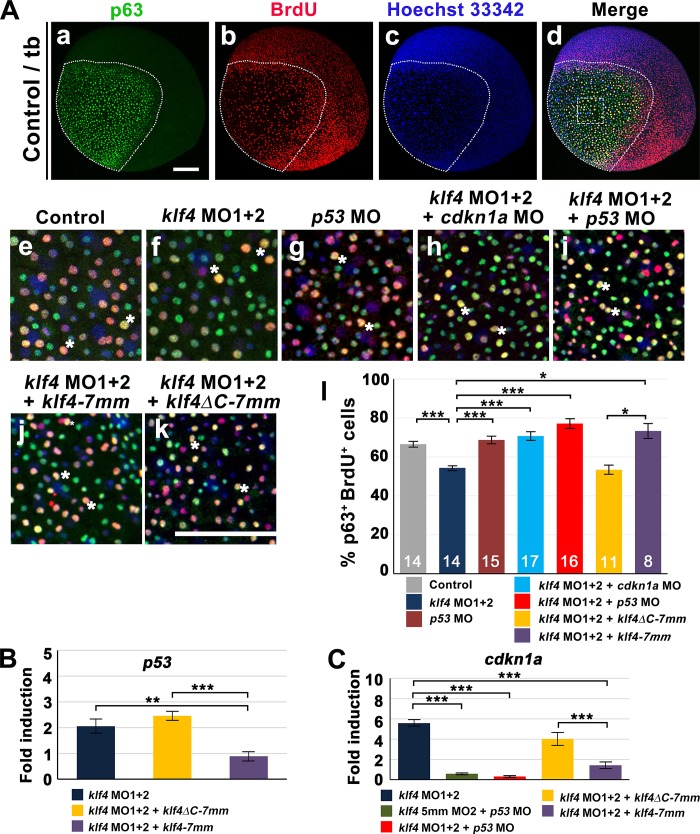
Klf4 maintains epidermal stem cell proliferation by repression of p53 expression.(A) BrdU and p63 labeling were performed on embryos injected with klf4 5mmMO2 (control) (a-e), combined klf4 MO1/klf4 MO2 (f), p53 MO (g), combined cdkn1a MO/ klf4 MO1/klf4 MO2 (h), combined p53 MO/klf4 MO1/klf4 MO2 (i), combined klf4-7mm mRNA/klf4 MO1/klf4 MO2 (j), or combined klf4ΔC-7mm mRNA/klf4 MO1/klf4 MO2 (k). Nuclei are counterstained with Hoechst 33342 (c). Both p63+ and p63+BrdU+ cell number were enumerated in the circled areas. Examples of p63 and BrdU colocalized cells (asterisk) are shown. The percentage of p63+BrdU+ cells in embryos after indicated treatments was quantified (l). (B) p53 expression in embryos injected with combined klf4 MO1/klf4 MO2, combined klf4-7mm mRNA/klf4 MO1/klf4 MO2, or combined klf4ΔC-7mm mRNA/klf4 MO1/klf4 MO2 was measured by RT-qPCR. (C) cdkn1a/p21 expression in embryos after indicated treatments was measured by RT-qPCR. Statistical significance was determined by Student’s t-test. *p < 0.05; **p < 0.01; ***p < 0.001. Scale bar, 50 μm. Error bars indicate standard error.